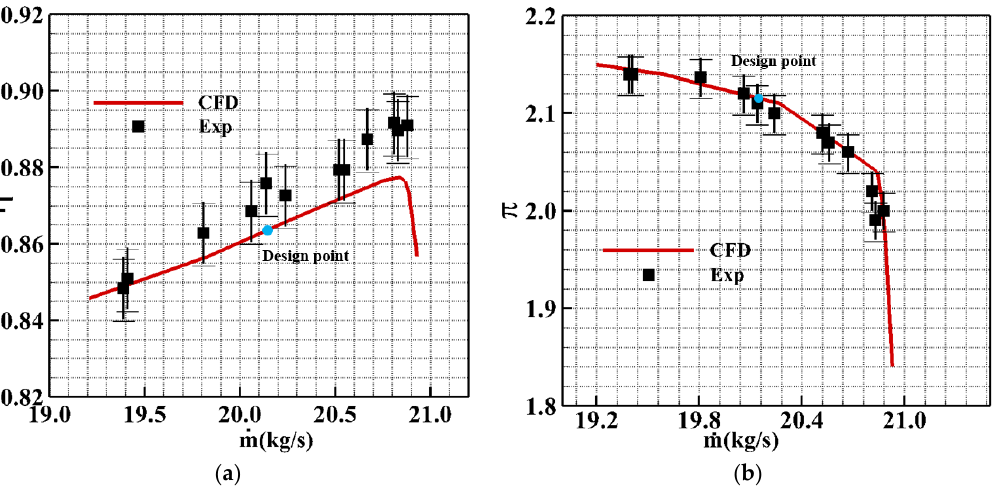
Figure 4. NASA Rotor 37 aerodynamic performance of the experiment and the simulation. ( a ) Flow mass rate vs. adiabatic efficiency; ( b ) Flow mass rate vs. total pressure ratio. In addition, Bruna et al. [23] also performed CFD calculations on NASA Rotor 37.